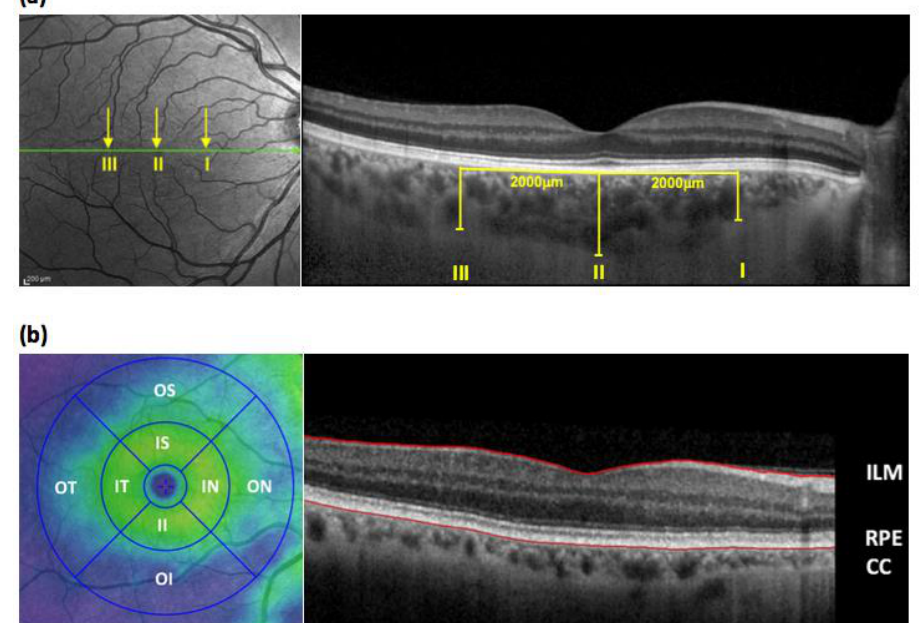
Figure 1. ( a ) The left panel is a representative en face retinal optical coherence tomography (OCT) image obtained using the Heidelberg SPECTRALIS ® OCT platform. The right panel is a cross sectional image taken at the level of the green line on the en face view. The line of the OCT scan passes through the fovea and optic disc. Choroidal thickness was measured manually at 3 locations on the macula using enhanced depth imaging technology (I: 2 mm nasal to the fovea, II = sub-foveal, III = 2 mm temporal to the fovea). ( b ) Sixty-one sequential horizontal line scans were performed covering the macular area. The retinal thickness of each area within the Early Treatment Diabetic Retinopathy